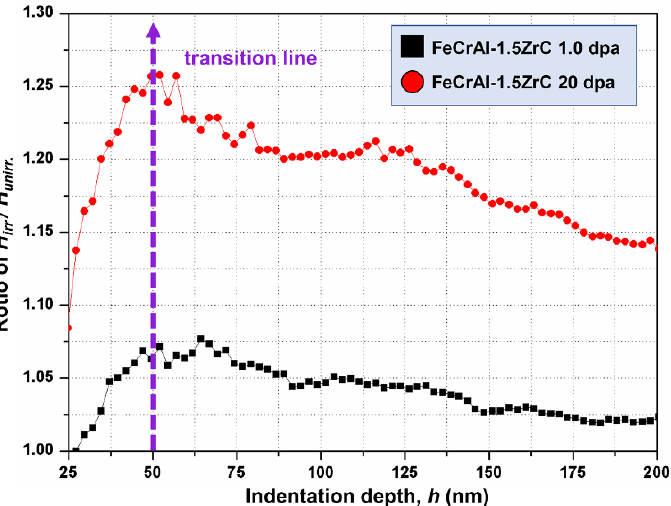
Figure 3. Dependence of the ratio of H irr / H unirr on indentation depth at the irradiation doses of 1.0 dpa and 20.0 dpa.